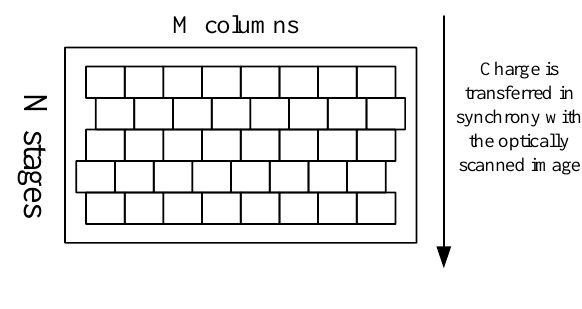
Figure 1 ． Schematic diagram of TDICCD under jitter effect in across-track